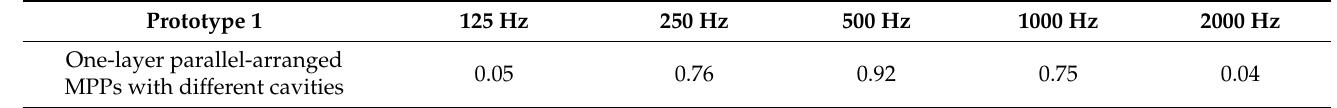
Table 4. Random absorption coefficients for the proposed one-layer parallel-arranged MPPs.